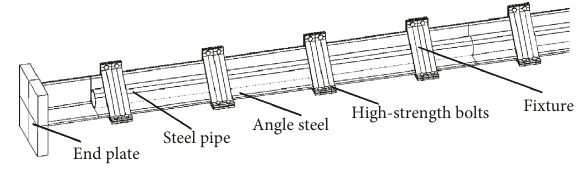
Figure 1: Component model.